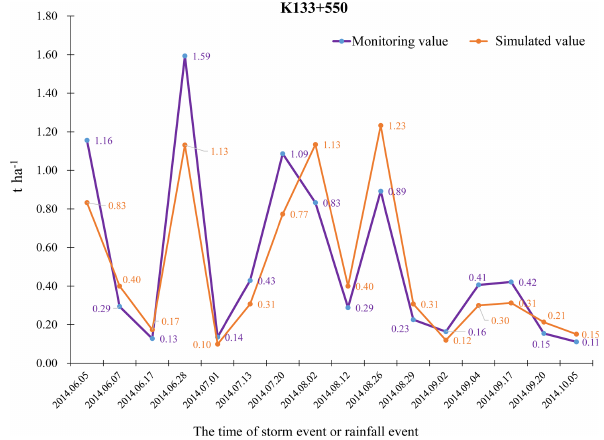
Figure 12. Comparison of model prediction and monitoring results (K133+550).